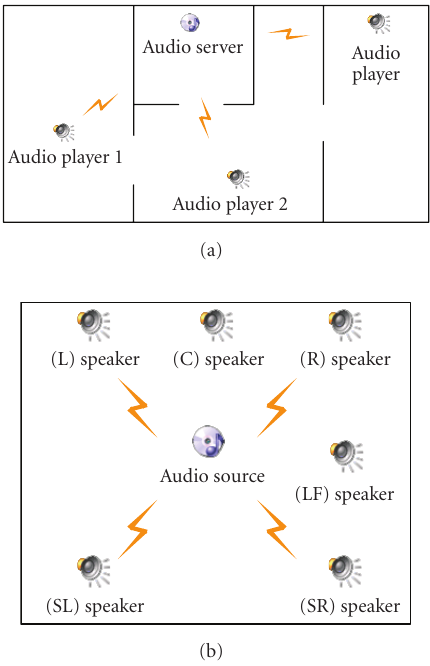
Figure 1: Typical WLAN digital audio systems: (a) simple point- to-point wireless audio delivery, (b) wireless multichannel playback